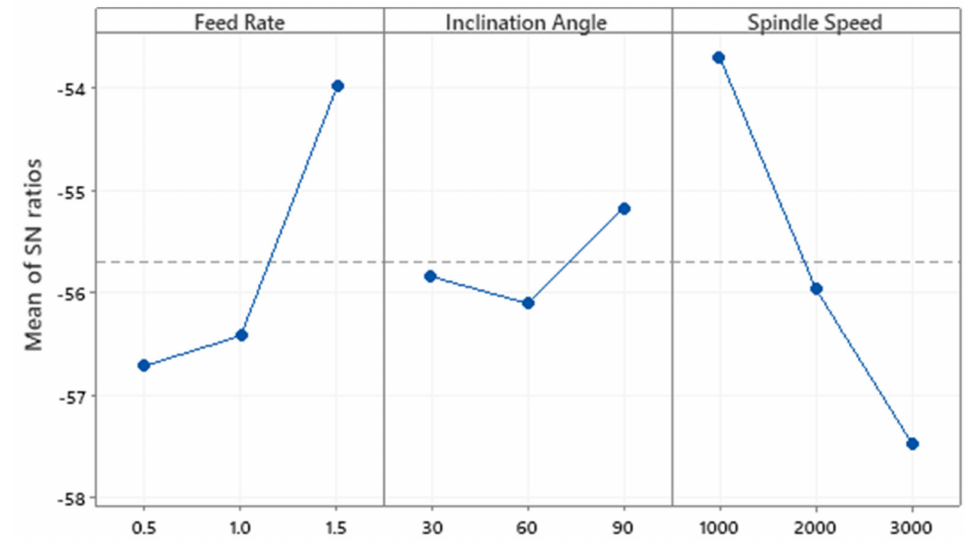
Figure 10. Main E ff ects plot of S / N ratios for